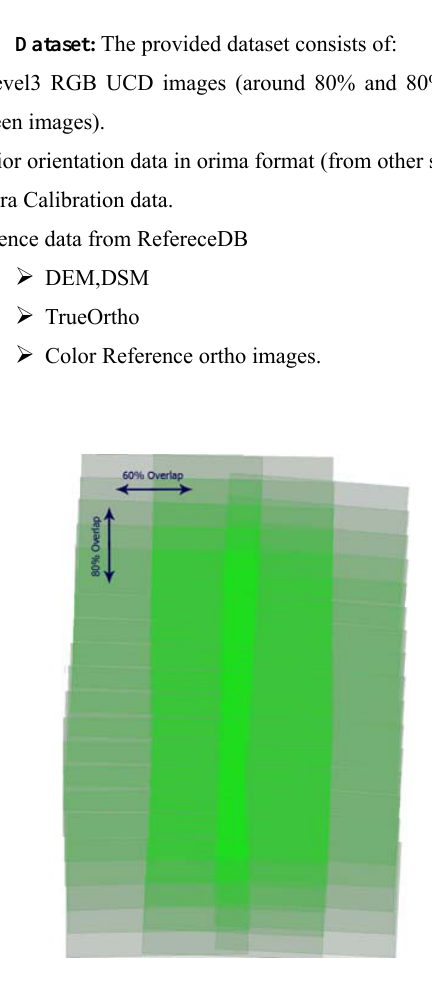
Figure 2. The outline of the provided